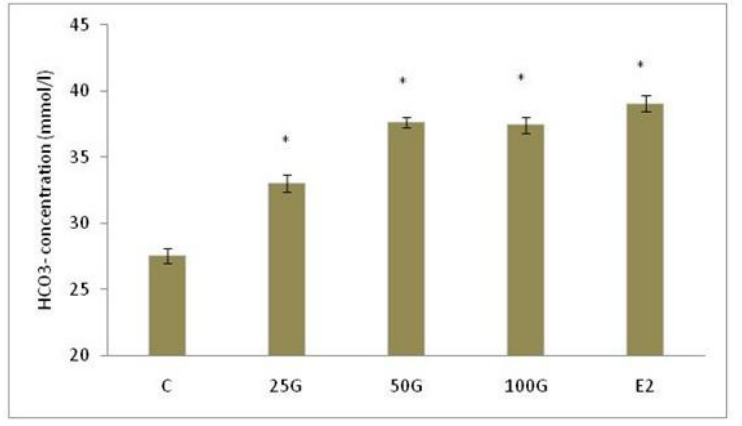
− ; ( B ) pH Figure 1. The effect of genistein at 25, 50 and 100 mg/kg/day on the ( A ) HCO 3 and ( C ) Na + concentration of the uterine luminal fluid in the ovariectomized SD rats. − concentration were observed with increasing doses of An increase in pH, Na + and HCO 3 − concentration were the highest following treatment with genistein. The pH and HCO 3 50 and 100 mg/kg/day genistein while Na + concentration was the highest following − concentration treatment with 100 mg/kg/day genistein. Changes in pH and HCO 3 following treatment with 50 and 100 mg/kg/day genistein were not statistically significant as compared to estrogen treatment. C: control; 25G: 25 mg/kg/day genistein; 50G: 50 mg/kg/day genistein; 100G: 100 mg/kg/day genistein; E2; estrogen. n = 6 rats per treatment group; * p < 0.05 as compared to